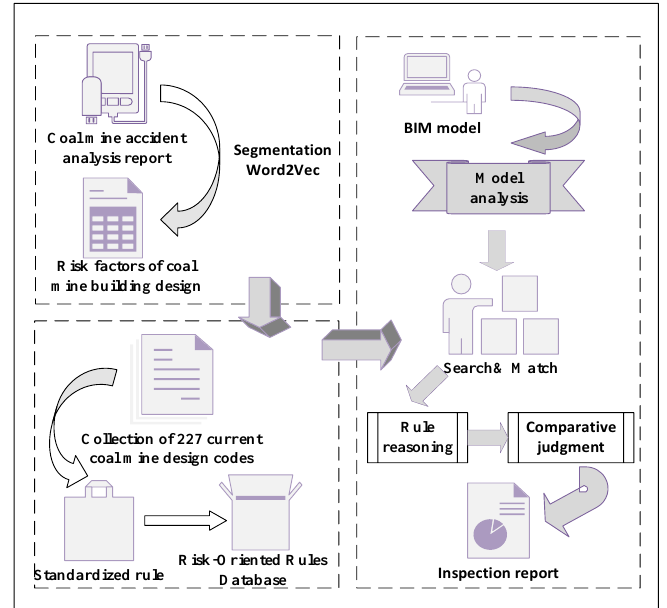
Figure 1. Research framework of this paper.